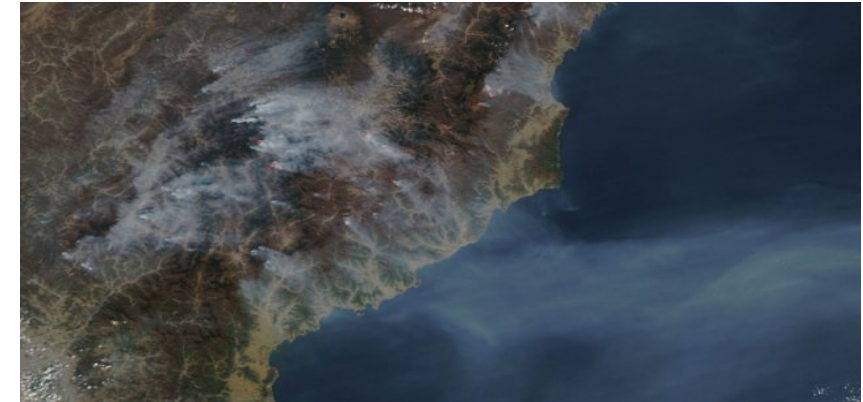
Figure 17 – Satellite image of the fire in North